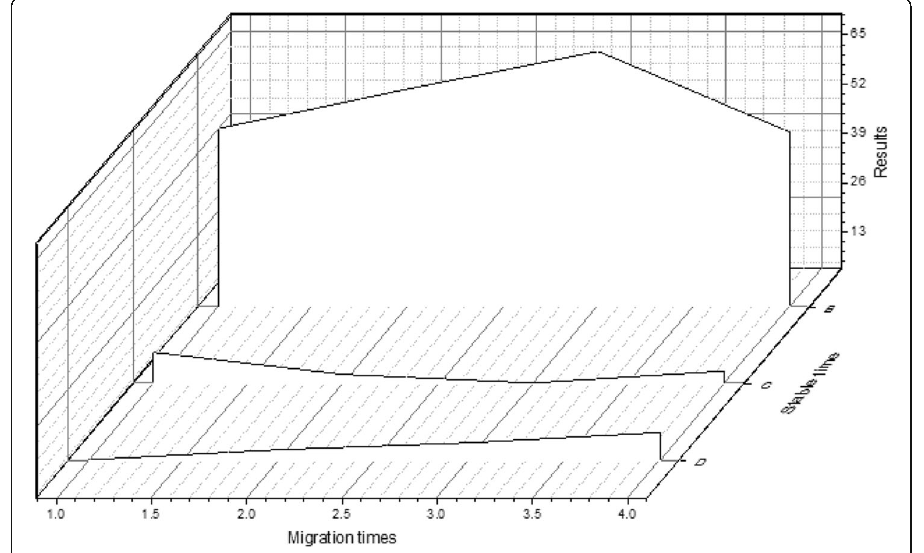
Fig. 4 Results of the new distributed state